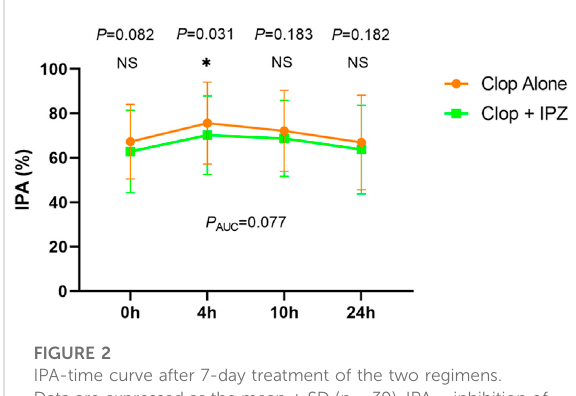
FIGURE 2 IPA-time curve after 7-day treatment of the two regimens. Data are expressed as the mean ± SD ( n = 39). IPA = inhibition of plateletaggregation;Clop=clopidogrel;IPZ=ilaprazole.NS=not signi fi cant. AUC = the area under the time-IPA% curve. * represents p < 0.05.